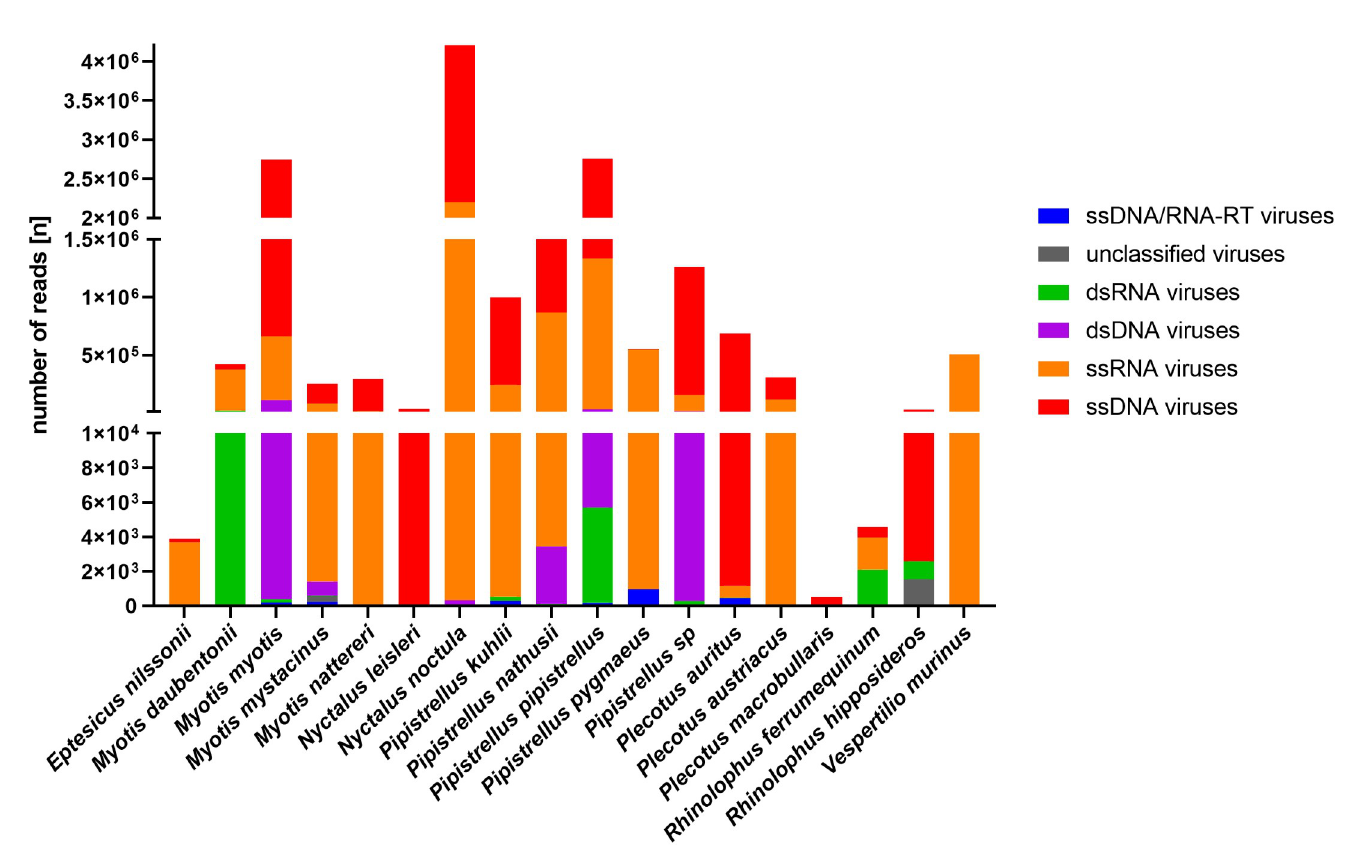
Fig 3. Distribution of viral reads according to genome classes. Because of the large differences in read numbers, the y-axis was divided into three parts to facilitate visualization of all virus genome classes in a single graph: part one from 0 to 1x 10 4 reads, part two from 1x 10 4 to 1.5x 10 6 reads, and part three from 2x 10 6 to > 4.x 10 6